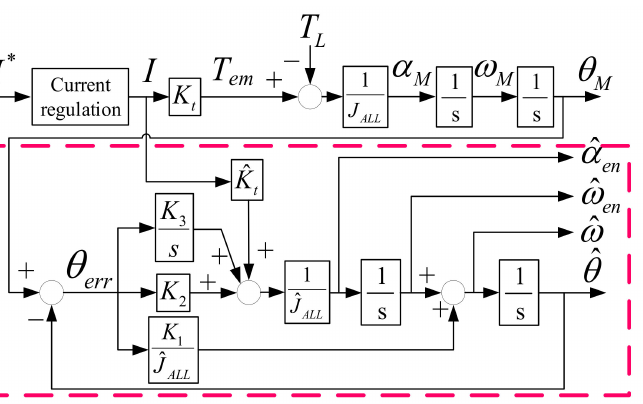
Figure 8. Speed estimation using the proposed observer with torque feedforward for phase delay